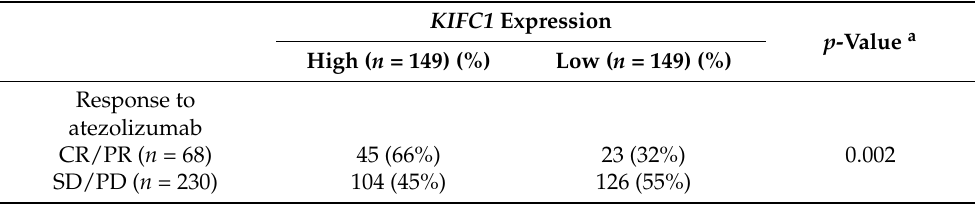
Table 9. Relationship between KIFC1 expression and the response to atezolizumab in IMvigor210